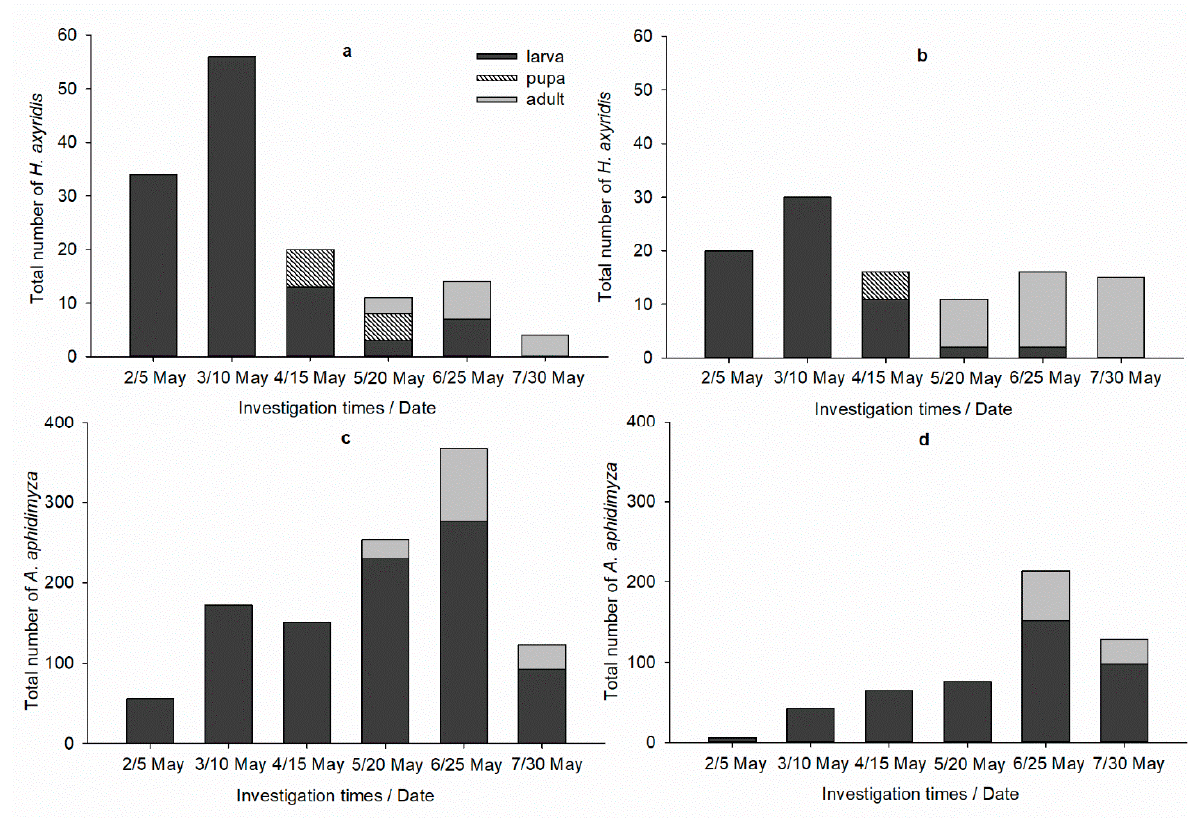
Figure 3. Number of predators in each treatment under high temperature. ( a ) H. axyridis , ( b ) low-dose thiacloprid and H. axyridis , ( c ) A. aphidimyza , ( d ) low-dose thiacloprid and A. aphidimyza .